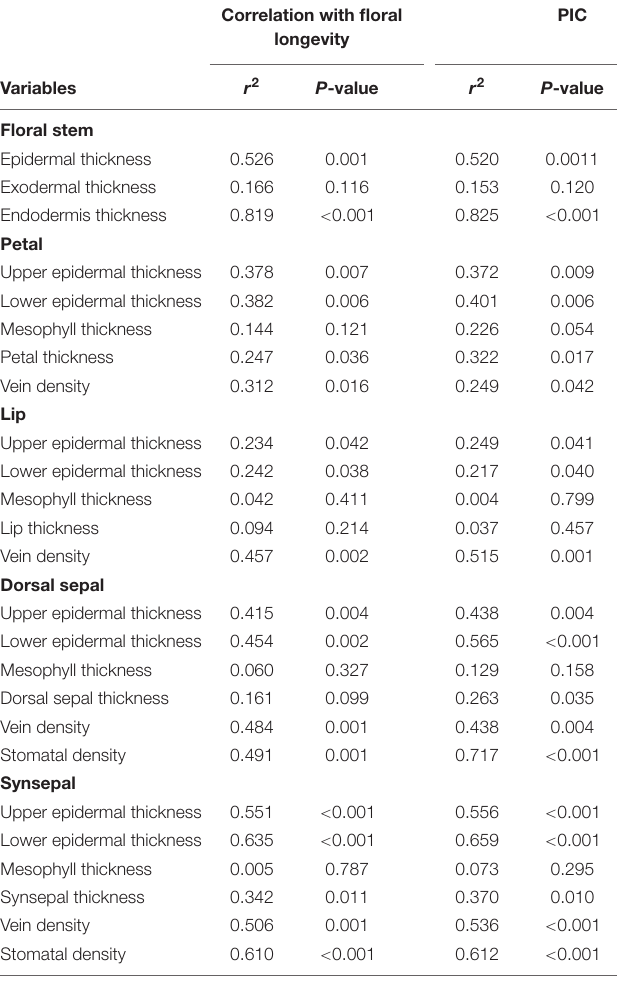
TABLE 3 | Pearson correlations and phylogenetically independent contrast (PIC) correlations for relationships between water-related traits with floral longevity in slipper